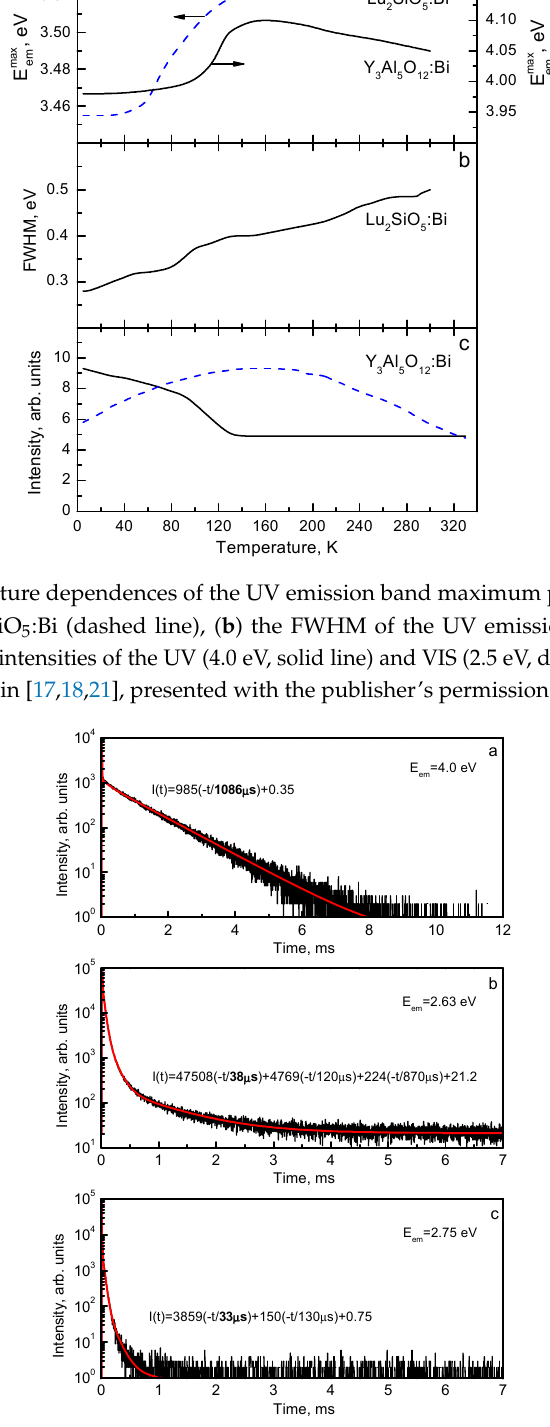
Figure 4. Decay curves of the ( a ) 4.0 eV, ( b ) 2.63 eV and ( c ) 2.75 eV emissions of Y 3 Al 5 O 12 :Bi at 4.2 K.